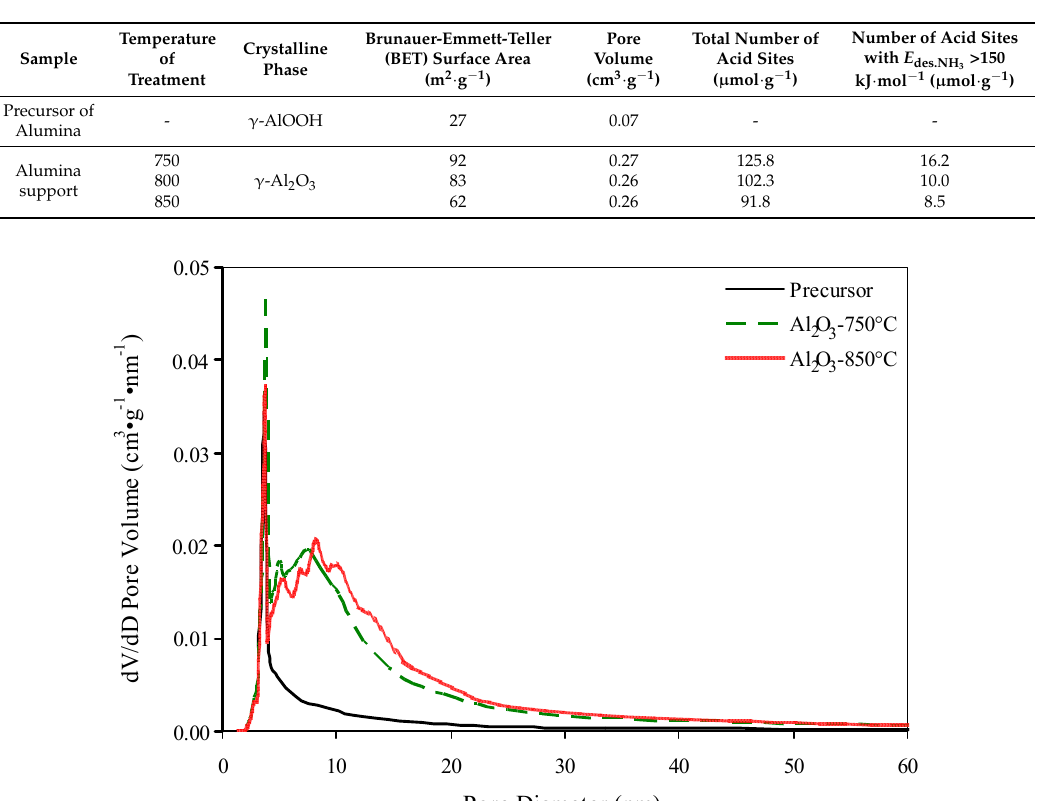
Figure 3. Pore size distribution for precursor of alumina and alumina supports, obtained at 750 °C and 850 °C. Table 1. Integral parameters of the porous system and the acidity of alumina supports.